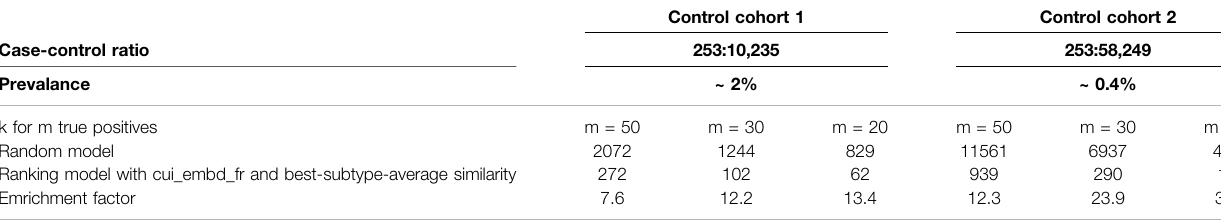
TABLE 3 | Performance in two unbalanced